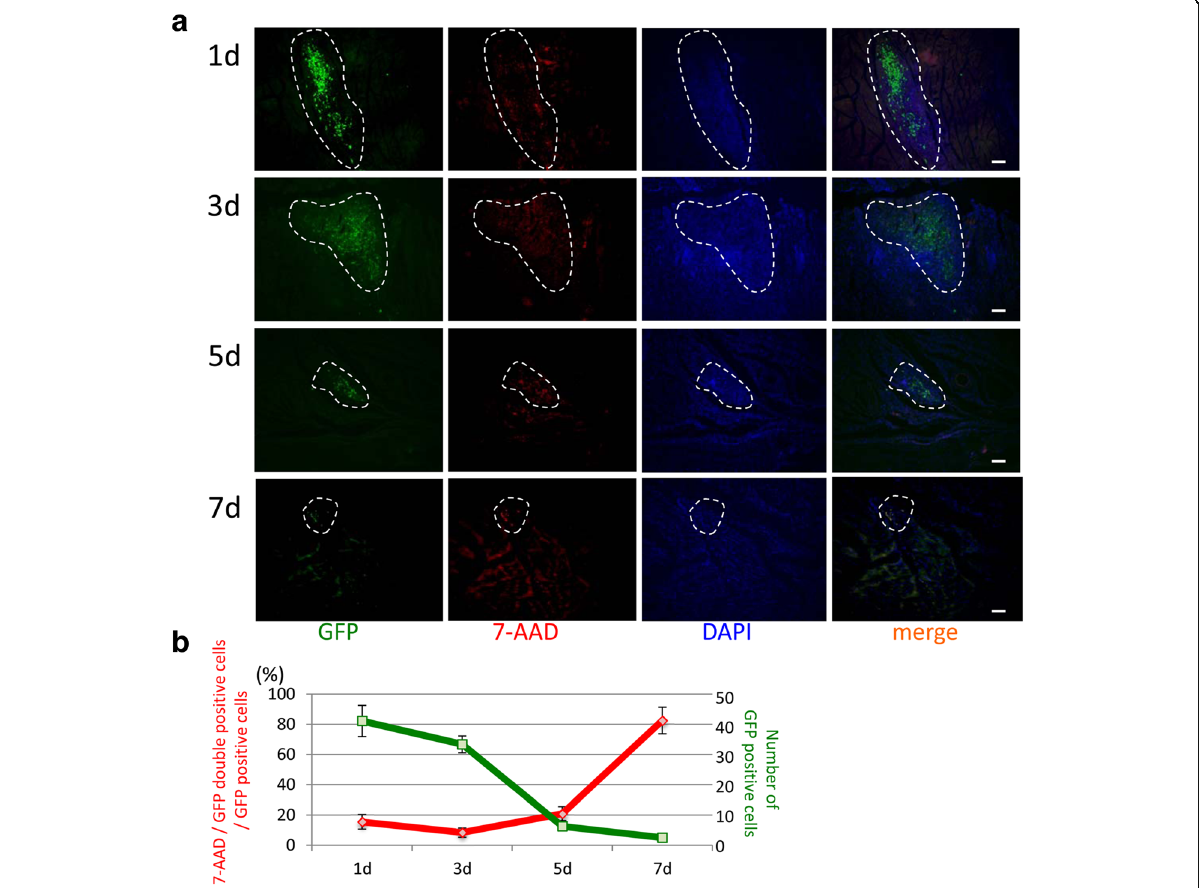
Fig. 6 MSC apoptosis after local administration. a GFP-conjugated MSCs (green) were stained by 7-AAD (red) as an apoptosis marker and nuclear DAPI (blue). (Bar = 80 μ m) b Quantitation of 7-AAD/GFP double-positive or GFP-positive cell numbers in the mass (bound area by white dotted line) after local MSC